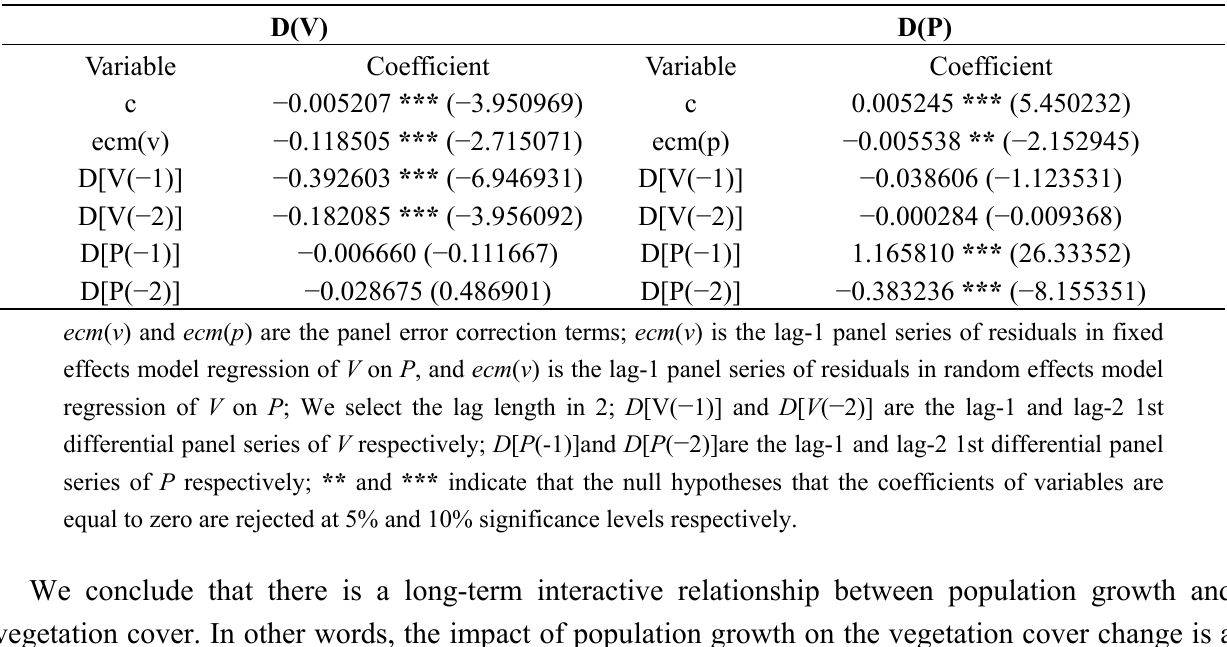
Table 5. The estimated results of the Panel Error Correction Model